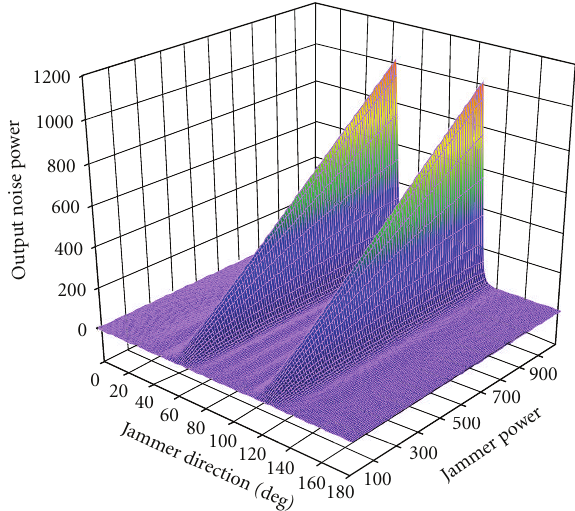
Figure 10: Output noise power of the antenna array versus jammer direction and jammer power. Two desired signals (60 ◦ , 120 ◦ , power: 0dB each) and one probing source with variable angle of arrival and variable power are considered [127].